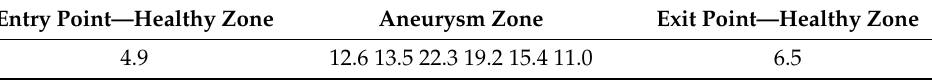
Figure 9. Stent placement—5 mm diameter, 123 mm length. Figure 4. Stent placement—5 mm diameter, 123 mm length. Table 1. Automated measurements along the aneurysm, opposite the direction of the blood flow, starting and ending with “healthy”